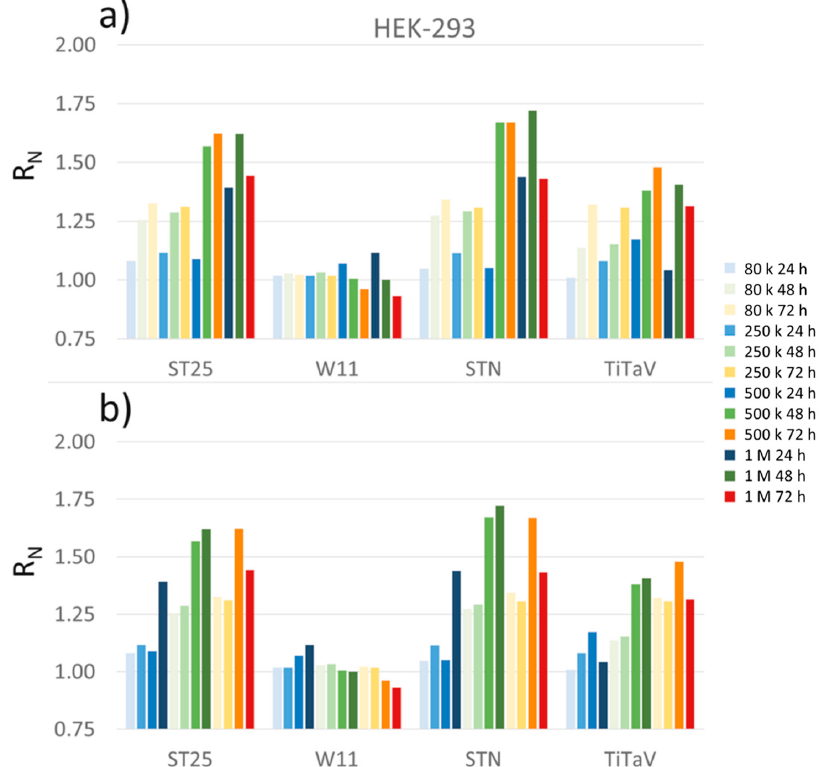
Figure 10 . Sensor responses to HEK-293 cell line. Cells plated at 80 K (lightest colors), 250 K (light colors), 500 K (medium dark colors), and 1 M (darkest colors) cells/dish, measured after withdrawn from the incubator at 24 h (blue), 48 h (green) and 72 h (orange); ( a ) cells sorted for the same concentration at different times of incubation; ( b ) cells sorted for the same time of incubation but at different concentrations.